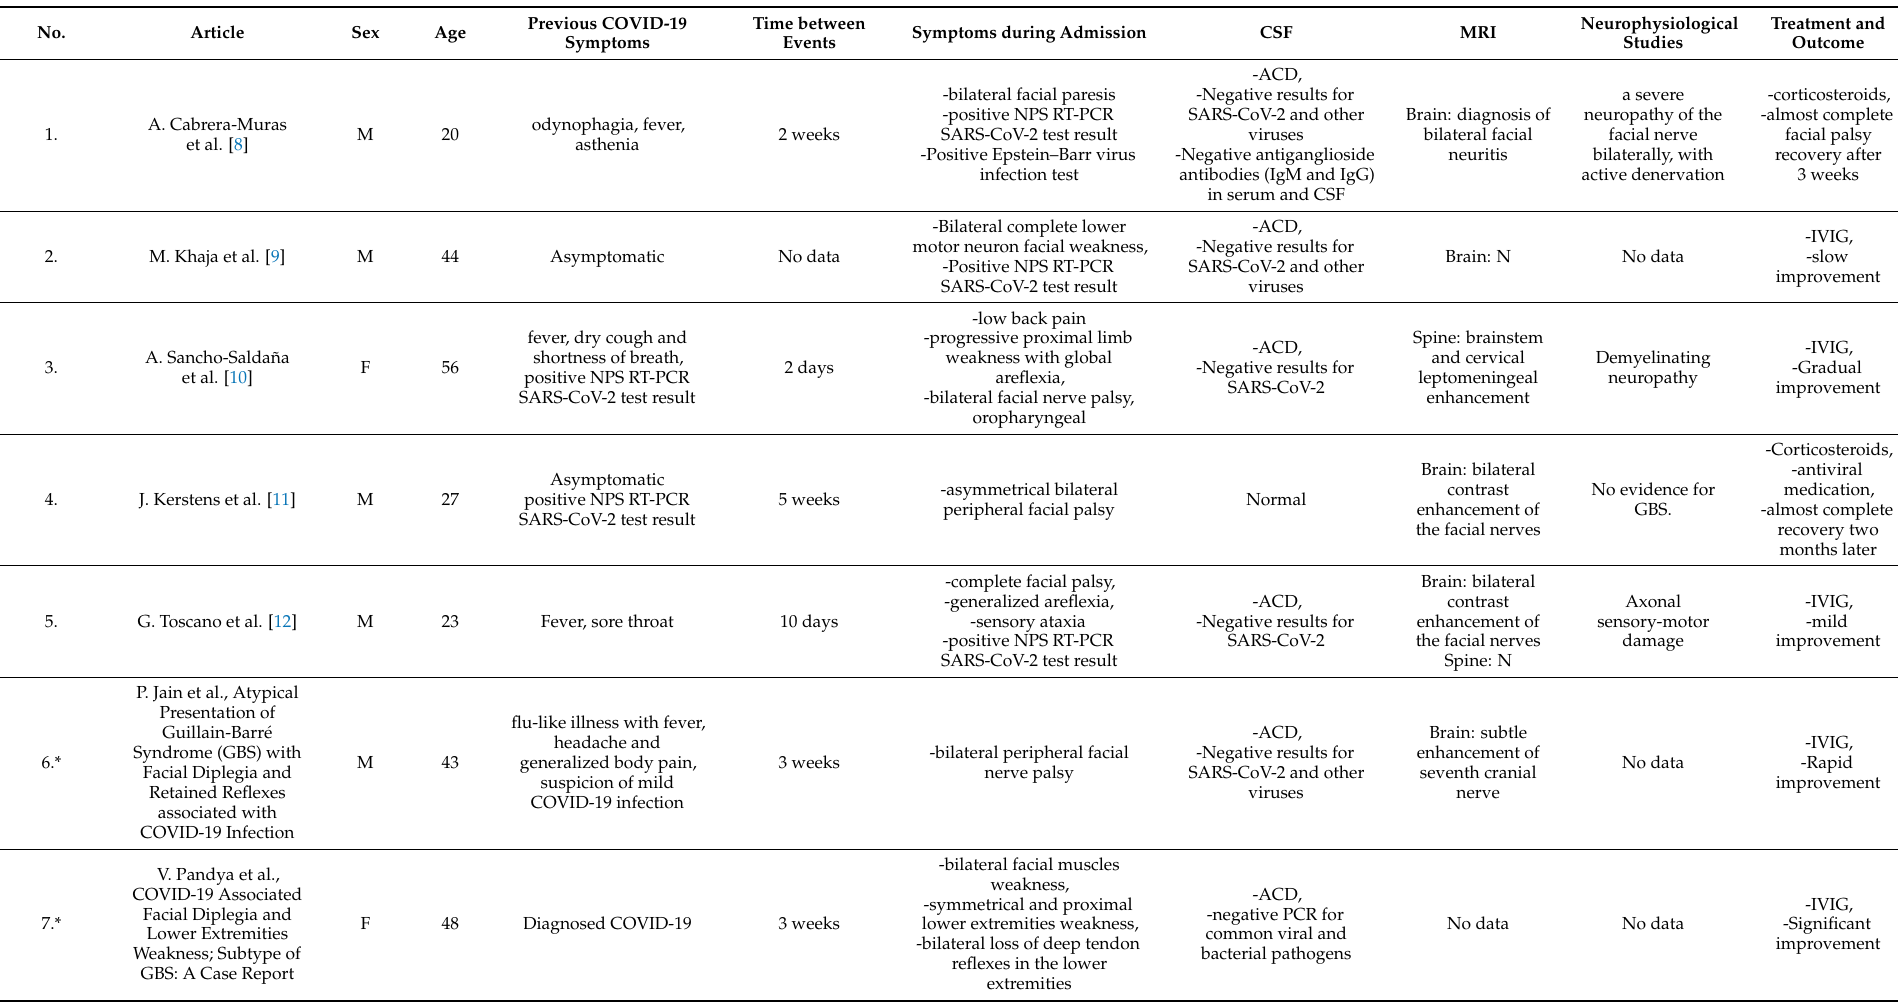
Table 1. Summary of clinical findings and diagnostic investigations of bilateral facial nerve palsy combined with SARS-CoV-2